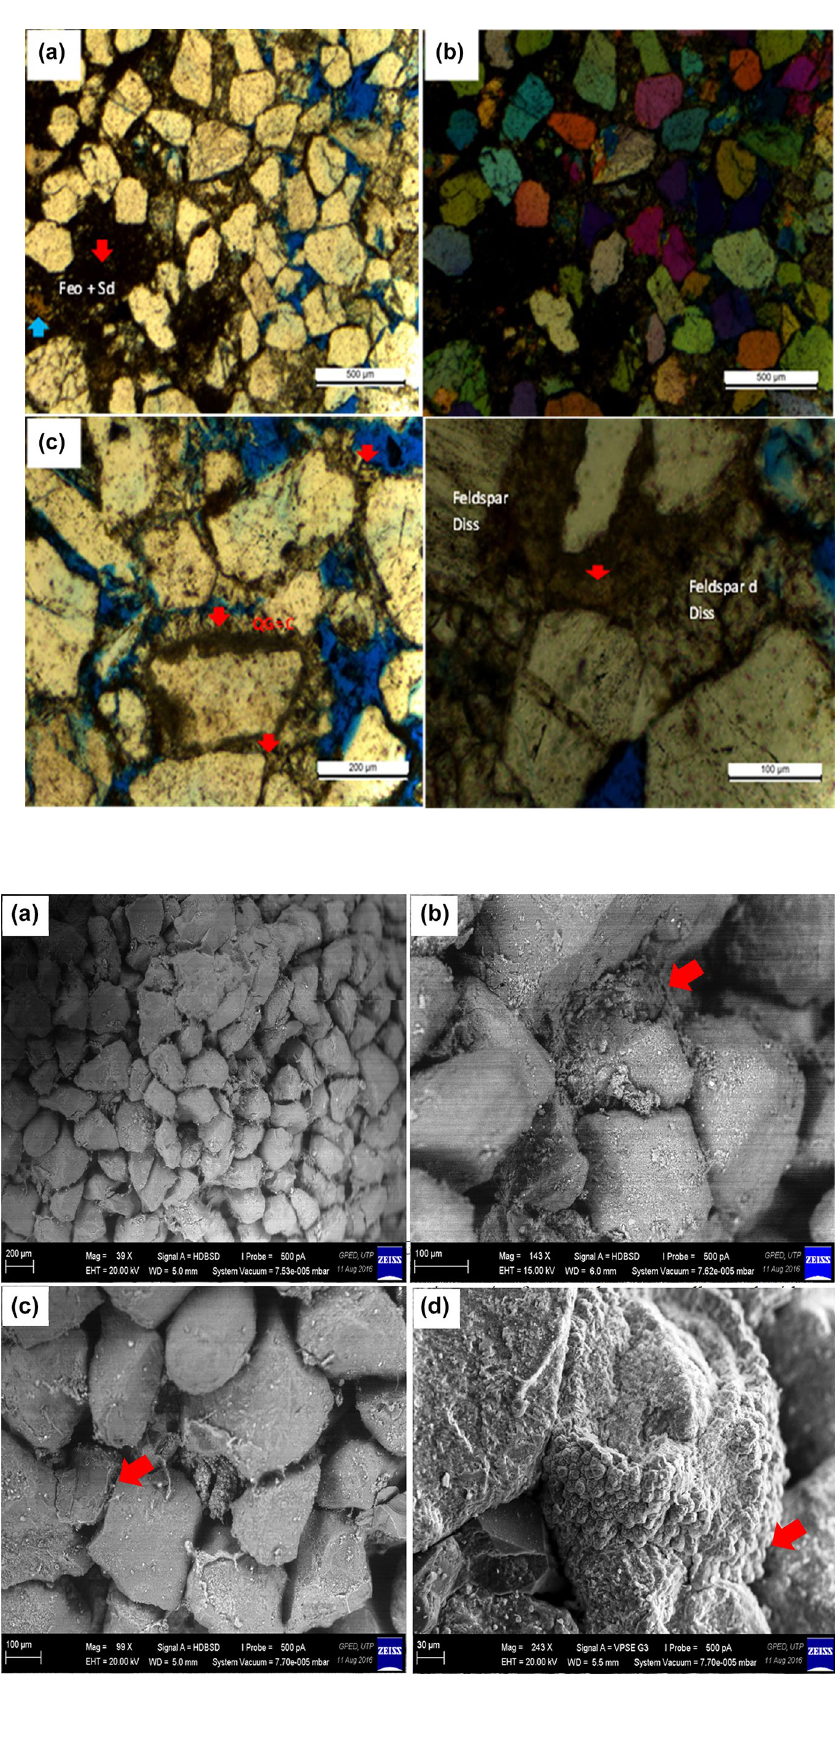
Fig. 4 Petrography of rock fabric and pore attributes to variations. ( a ) Mineral altera- tion, ( b ) a XPL of opaque FeO, siderite and clay fractions filling pore spaces, ( c ) Quartz growth/ cement and pore attribute modi- fication, ( d ) Feldspar dissolu- tion in MCGS Lithofacies (WB C4B7) sandstone and kaolinite filling a pore (red arrow) at depth 1399.55 m from WB field